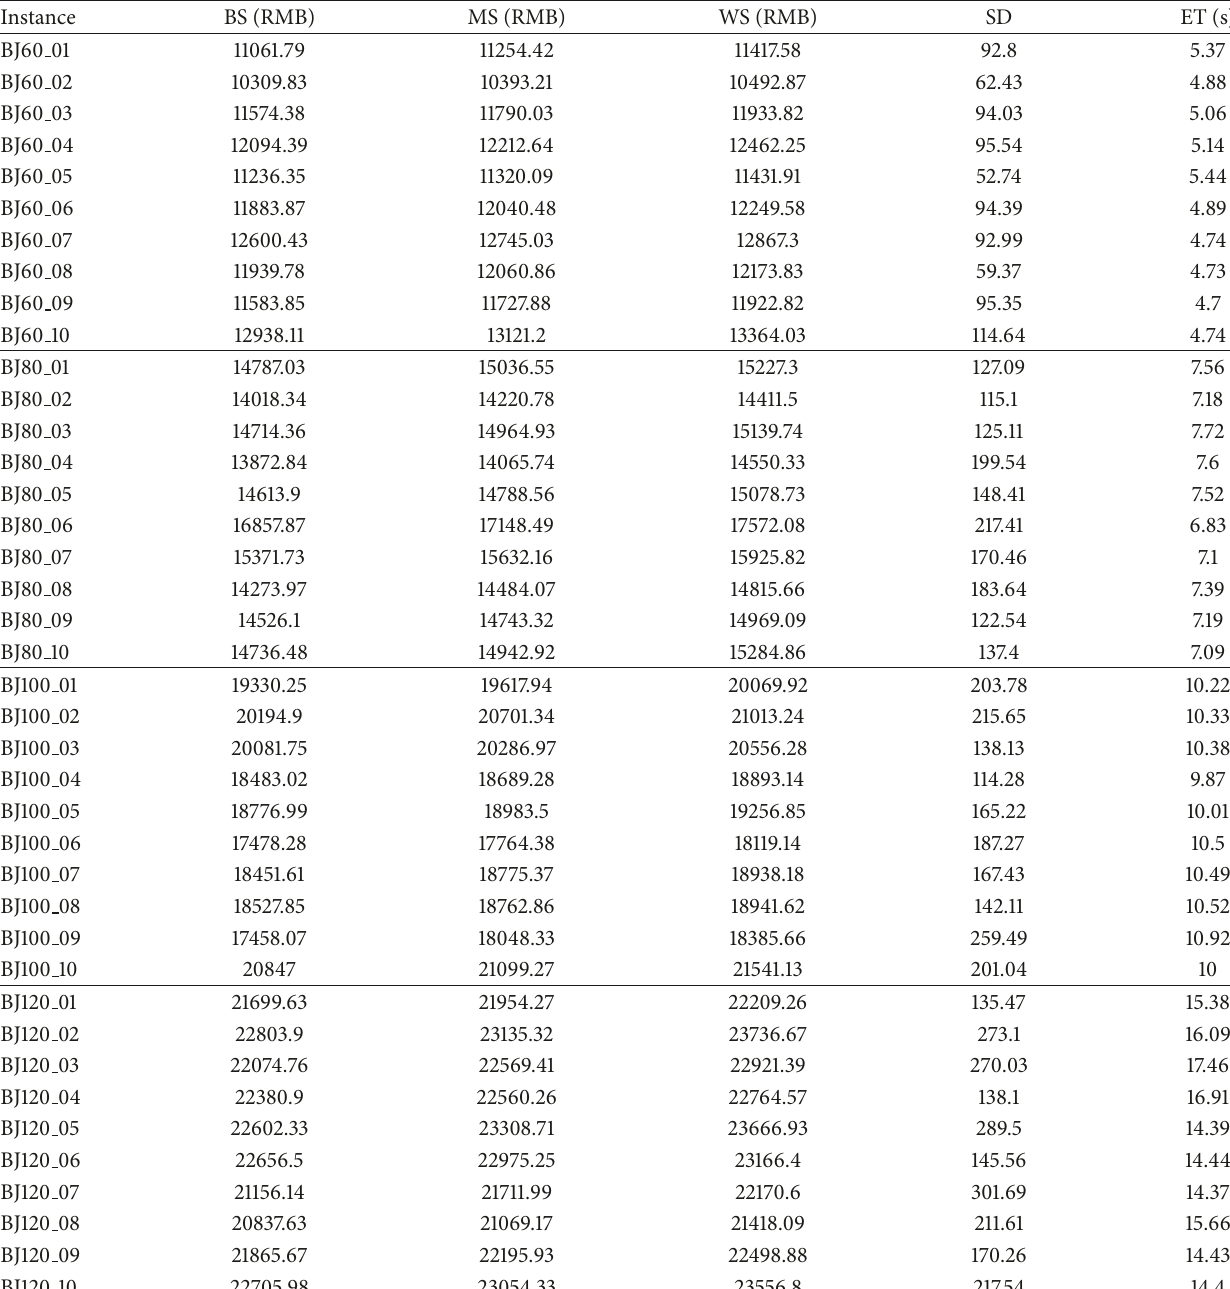
Table 10: Computational results on larger scale